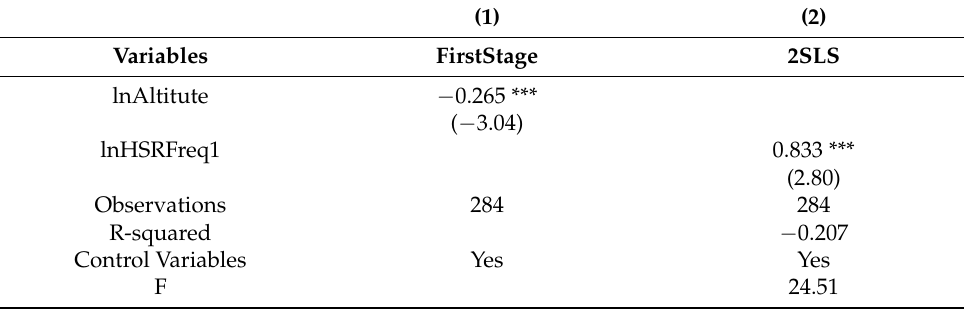
Table 8. The results of the regression using the instrumental